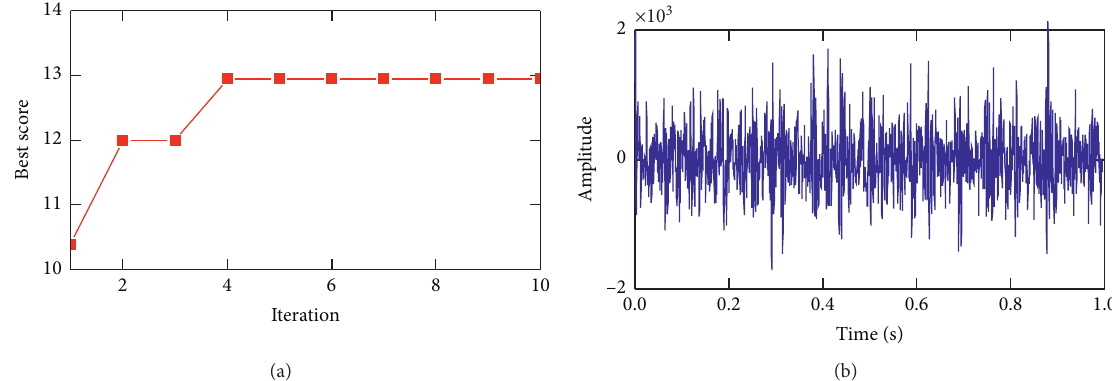
Figure 12: Case2: (a) fitness convergence curve for PPCA optimization; (b) time-domain diagram after noise reduction by